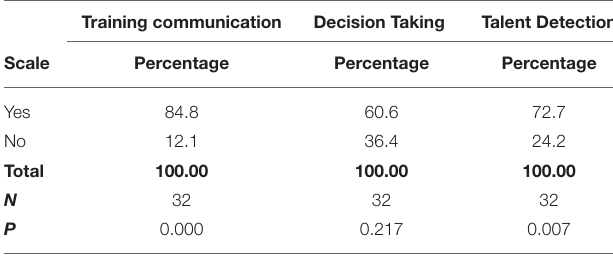
TABLE 4 | Validity of debate as a training solution for different business